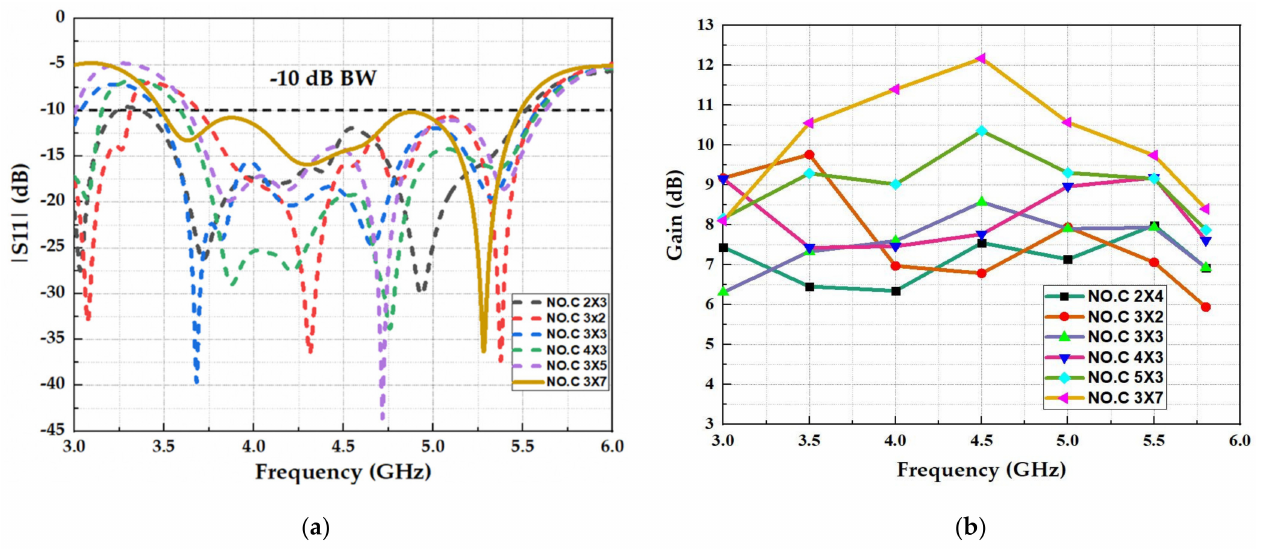
Figure 9. Simulated parametric study for the number of unit cells: ( a ) reflection coefficient (S11) and ( b ) realized